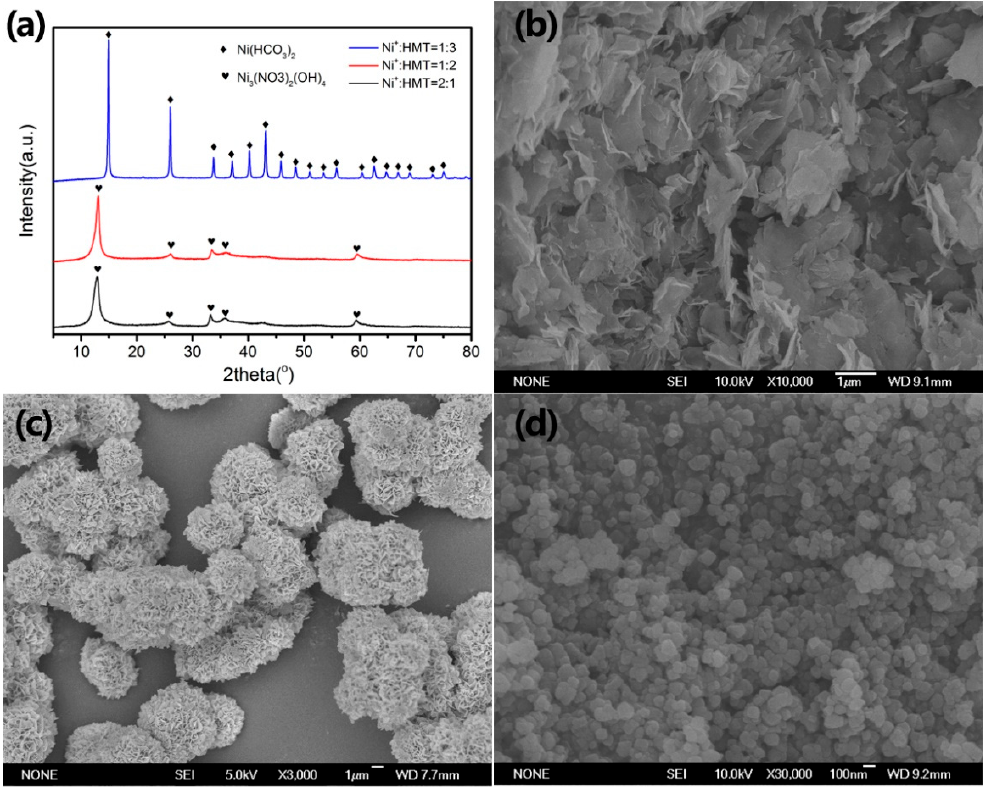
Figure 1. ( a ) XRD (Cu K α , λ = 0.15406 nm) patterns and SEM (secondary electron imaging mode) images of as-prepared precursor obtained by different ratios of Ni 2+ /HMT (hexamethylenetetramine): ( b ) 2:1; ( c ) 1:2; and ( d ) 1:3.